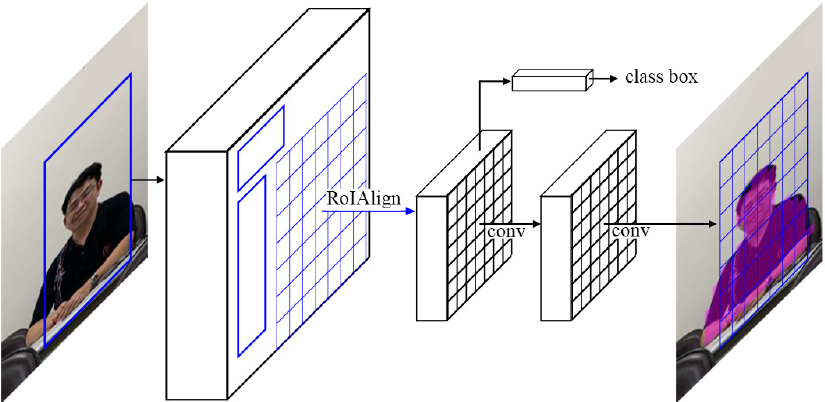
Figure 5. Mask region-based convolutional neural network (R-CNN) framework for instance segmentation